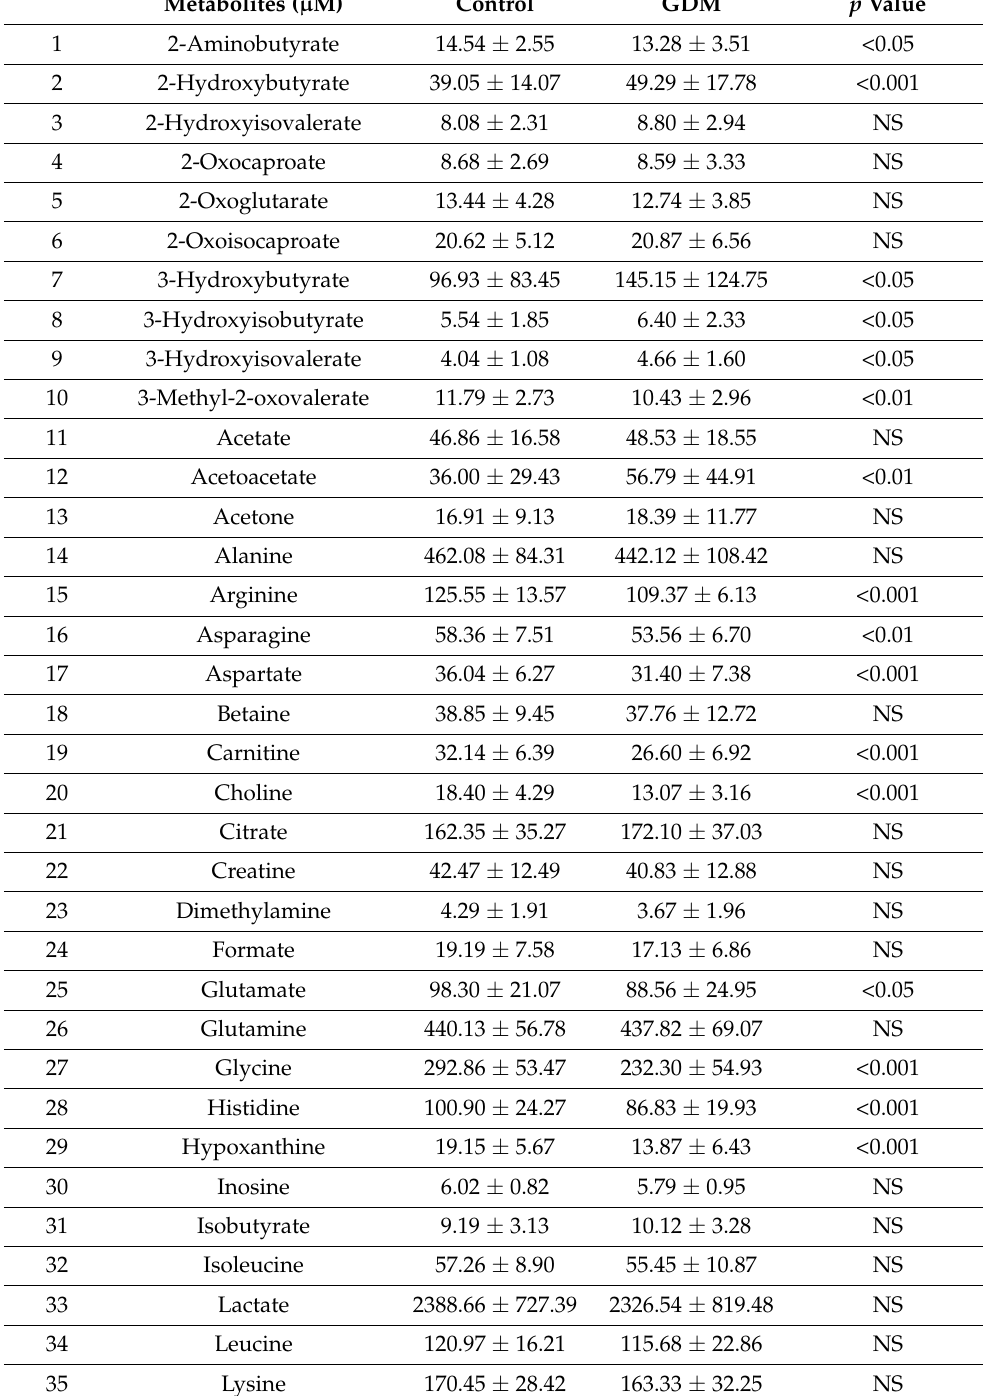
Table 2. Concentrations of serum metabolites in the study